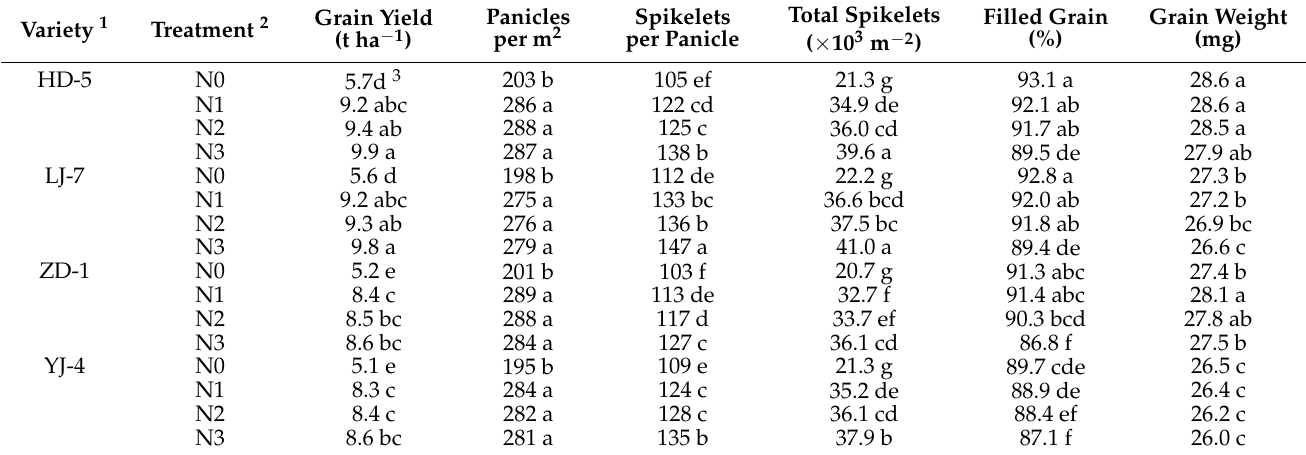
Table 4. Grain yield and yield components of rice under various N managements.